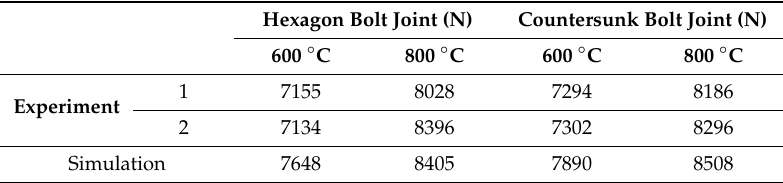
Table 3. The critical loads of the experiment and